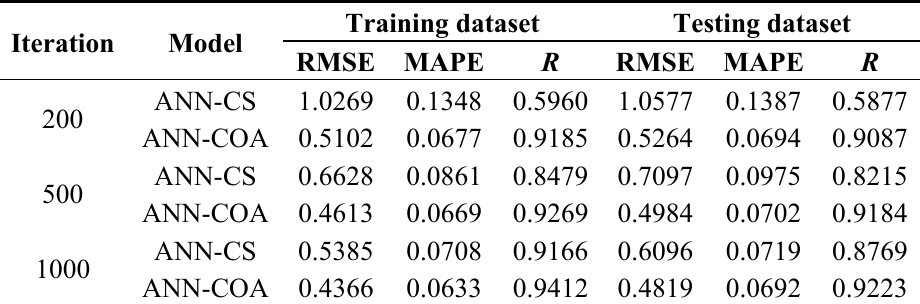
Table 2. Comparison of ANN-CS and the ANN-COA.